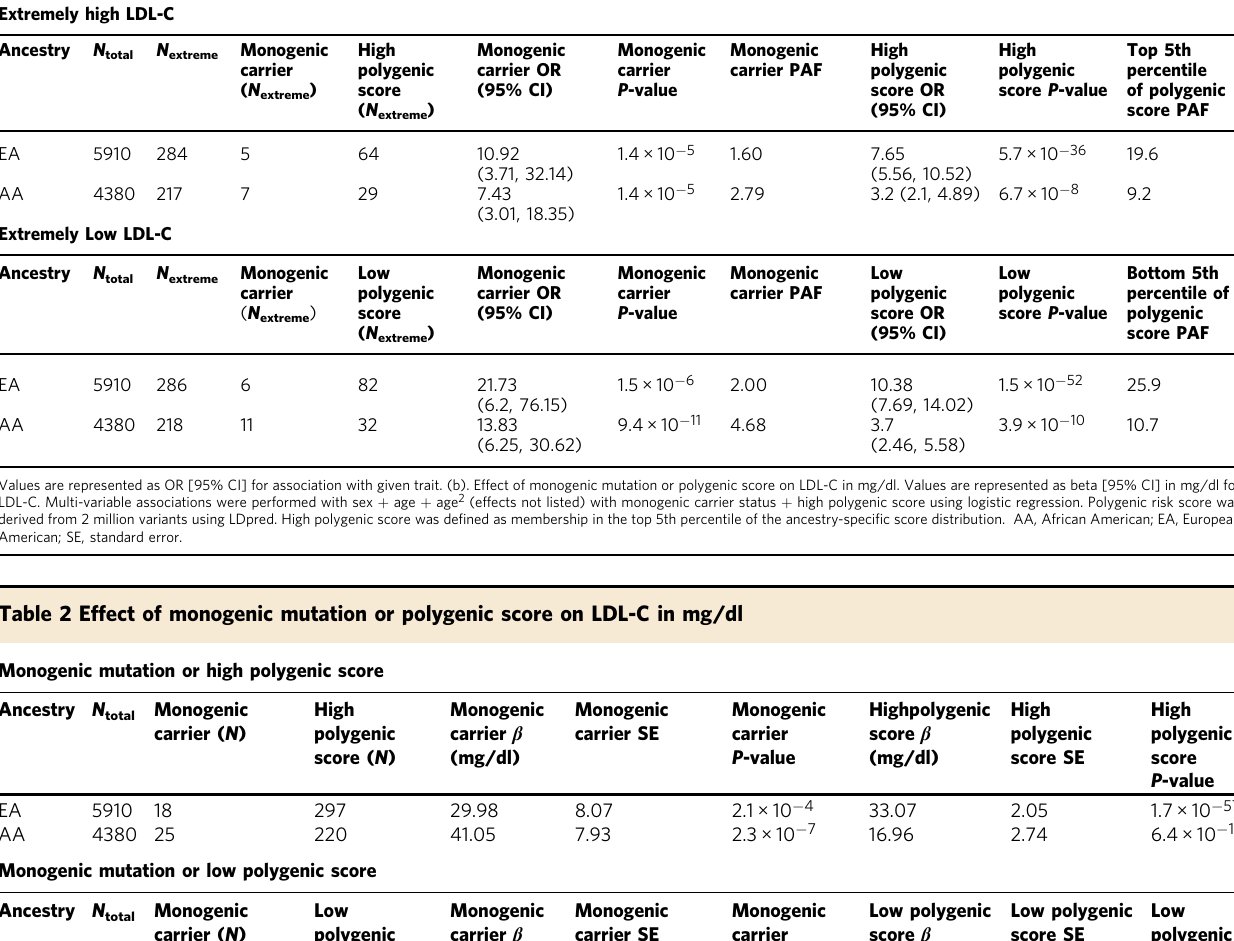
Table 1 Effect of monogenic mutation or polygenic score on odds for extremely high or low LDL-C Extremely high LDL-C Ancestry N total N extreme Monogenic carrier